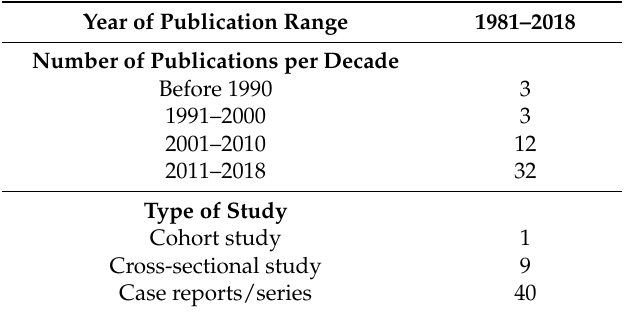
Table 1. Characteristics of included